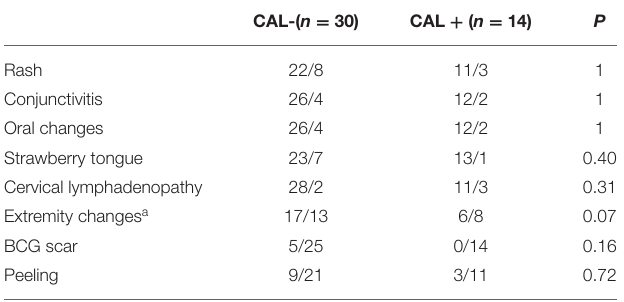
TABLE 2 | Clinical characteristics of patients of Kawasaki disease (KD) patients.